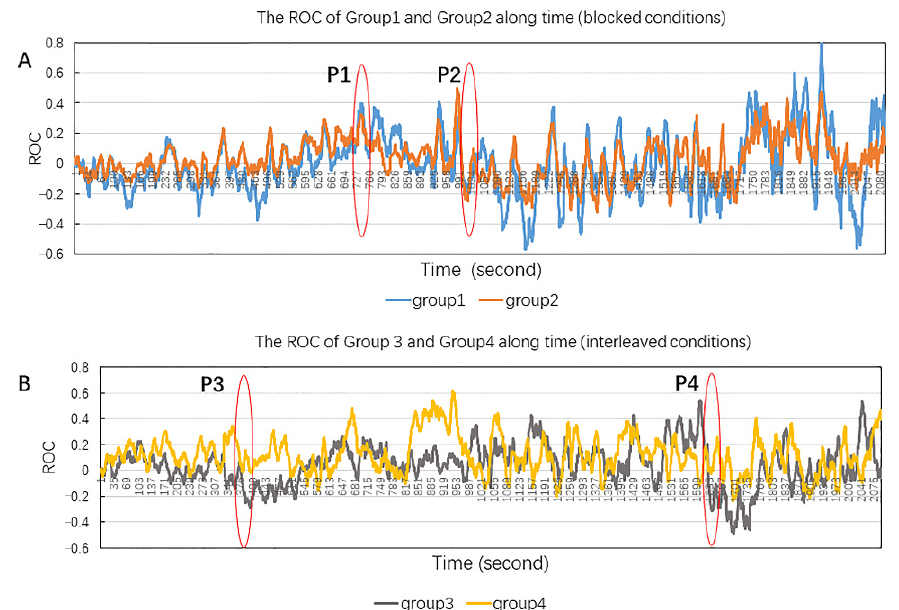
Figure 5. The ROC of average attention level of blocked conditions ( A ) and interleaving conditions ( B ) throughout the learning sessions. P1 is the early high point of blocked conditions; P2 is the turning point of attention going down as compared to the attention level at the beginning; P3 is the first point of time with the attention of Group 3 (I-A) going down; P4 is the turning point of attention declining for the interleaving conditions.